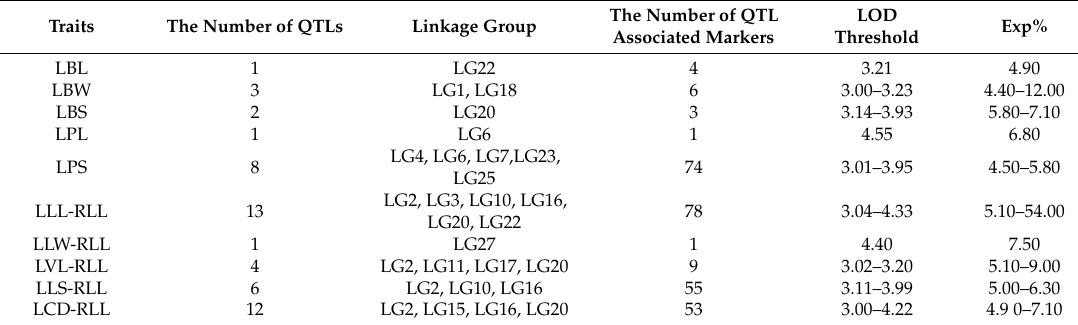
Table 6. The QTLs test for 10 quantitative traits of leaf in